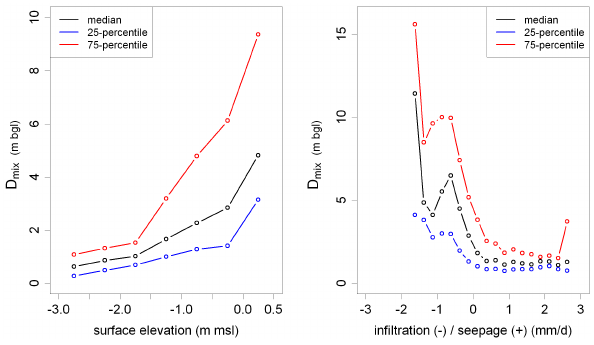
Fig. 15. Relation of D mix derived from 84300 HEM-measurements with (a) surface elevation (mm.s.l.) and (b) infiltration and seepage flux (mmd − 1 ). The 25-, 50- and 75-percentile of D mix was deter- mined and plotted for different classes of surface elevation and flux (dots represent middle of